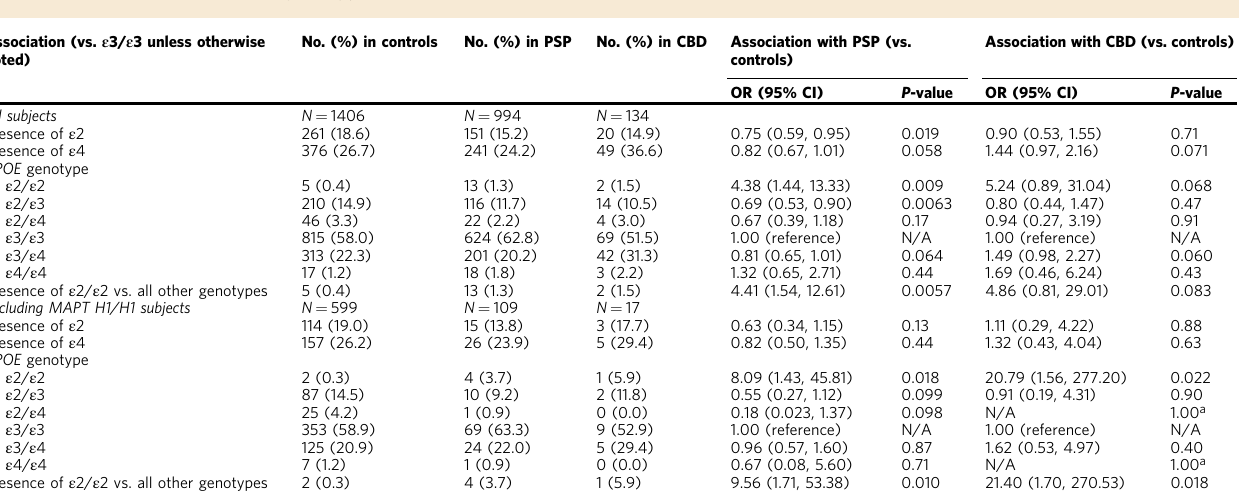
No. (%) in controls No. (%) in PSP No. (%) in CBD Association with PSP (vs.